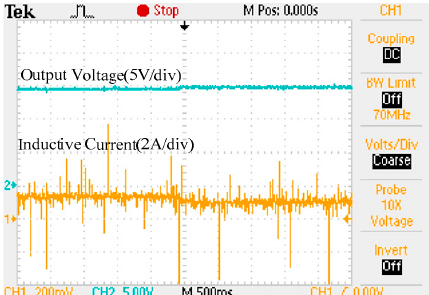
Figure 17. Experimental step ‐ load waveforms of the output voltage and inductive current under the TSM + DOB controller. Energies 2018 , 11 , x